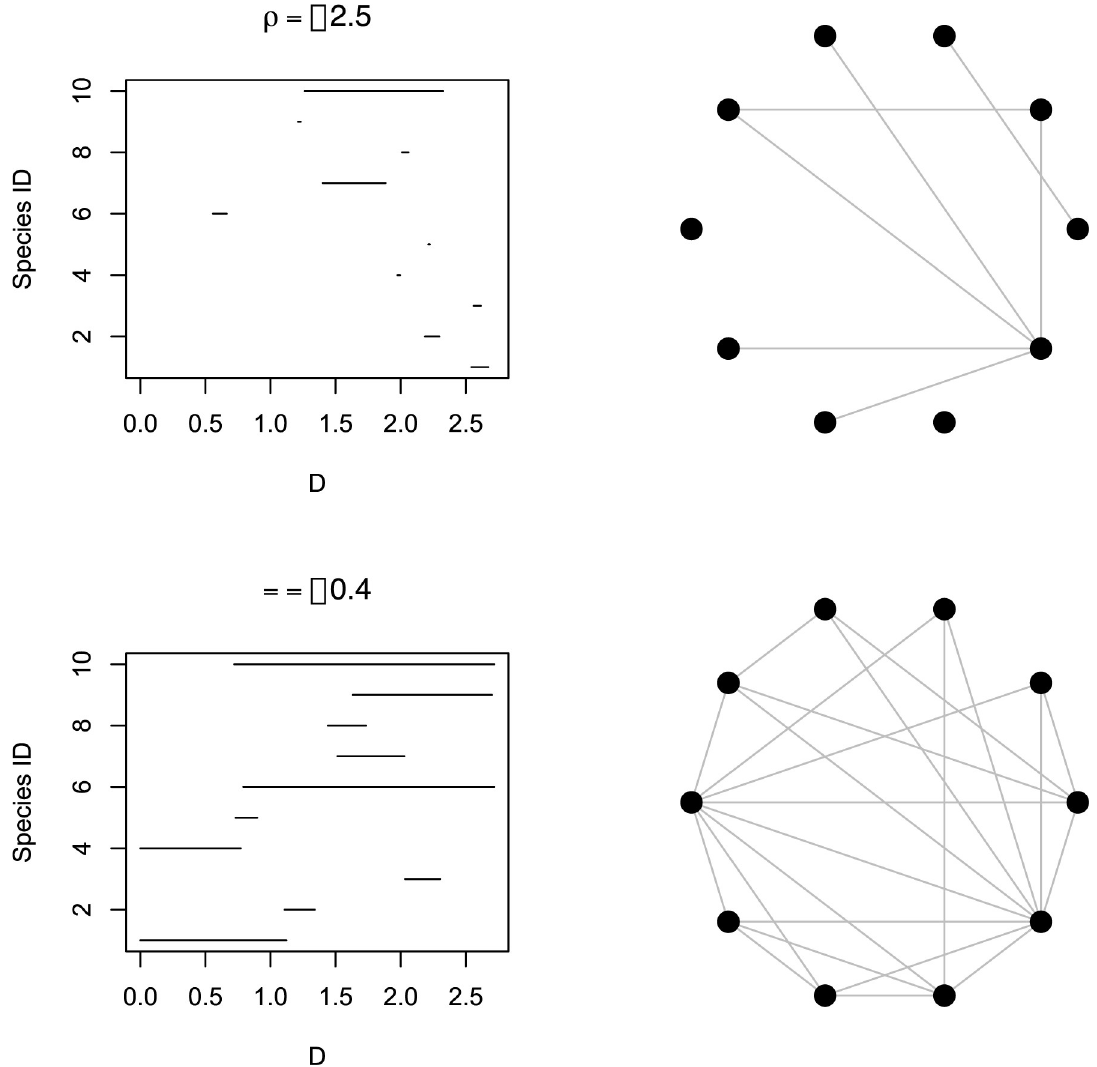
Fig 2. How variation in ρ would affect the pattern of range overlap and the resulting overlap network. ρ corresponds to the ratio between mean range size and the size of the entire domain D . The first row represents a situation in which the average range size is small with respect to the domain D , leading to little overlap and a sparse overlap network, whereas the second row reflects how a larger ρ would not necessarily make all species become distributed across D , yet the resulting overlap network shows considerable